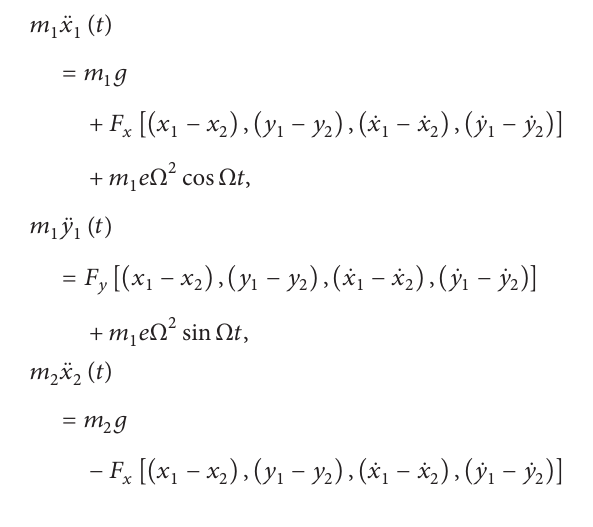
coupled with the air bag and floating-raft device can be expressed